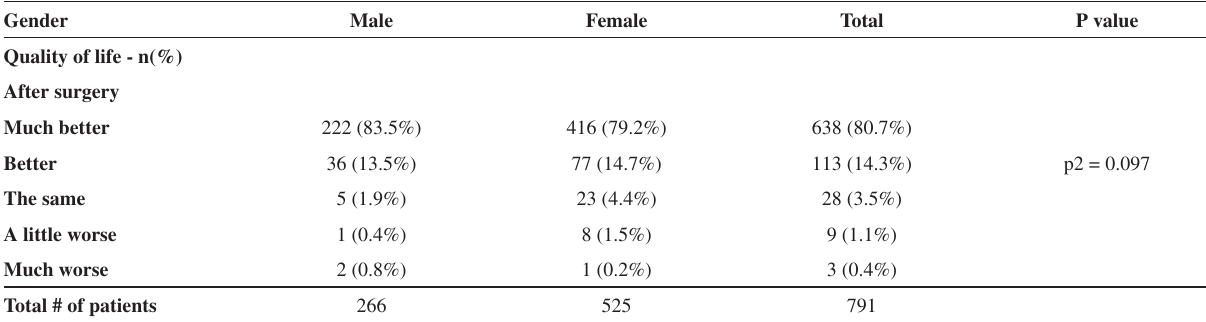
Table 3 - Quality of life after